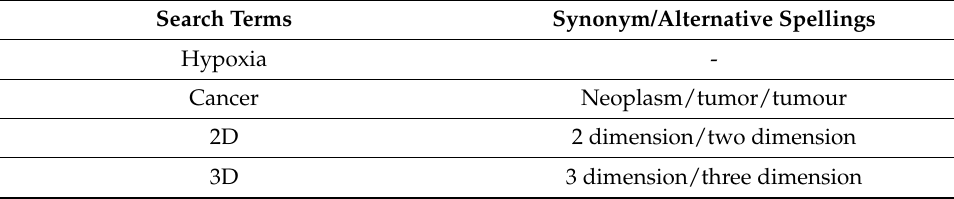
Table 1. Search terms.